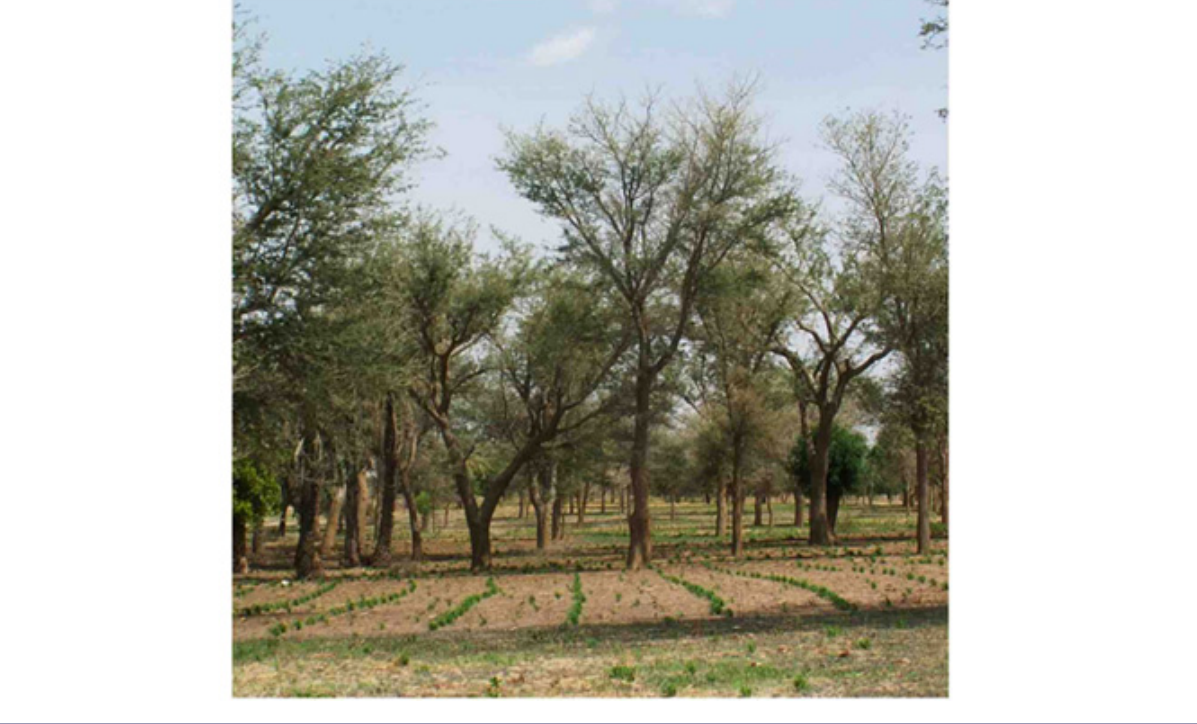
Fig. 3 . Agro-forestry in the area in the Maradi/Zinder region of Niger which was regreened by farmer- managed natural regeneration